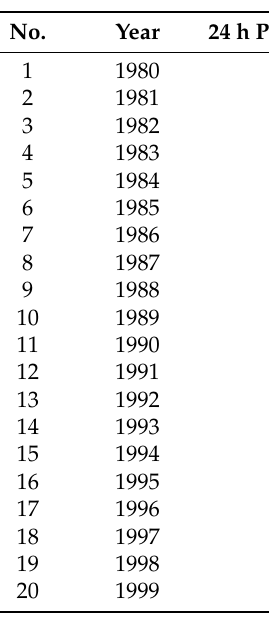
Table 1. Maximum daily rainfall for duration of